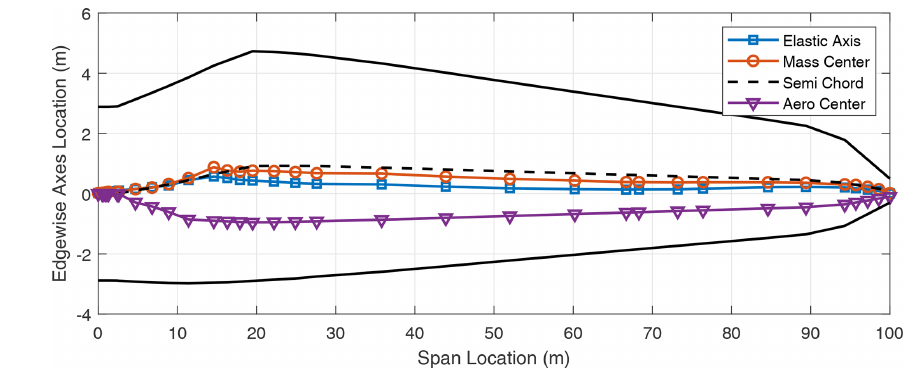
Figure A5. Planform for the SNL100-01 turbine blade.